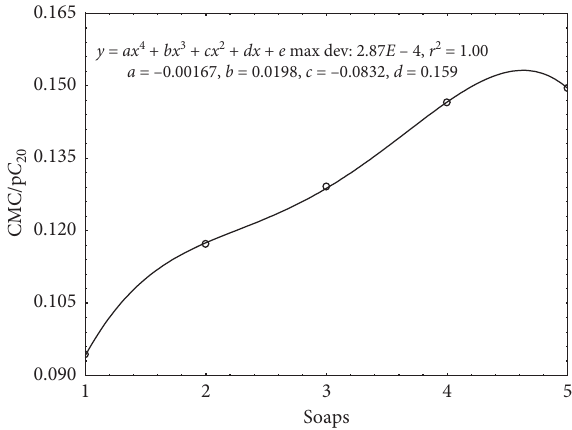
Figure 17: Variation of ( CMC/ pC